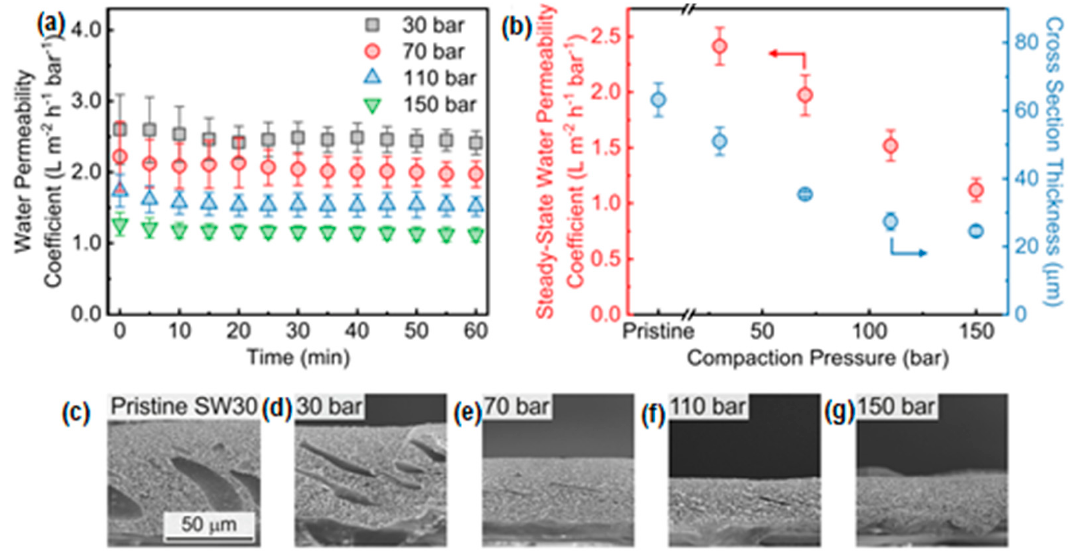
Figure 3. Characterization of commercial SW30 thin-film composite membranes following compac- tion at hydraulic pressures up to 150 bar ( a – g ). Reprinted with permission from Ref. [43]. Copyright 2020 Elsevier.